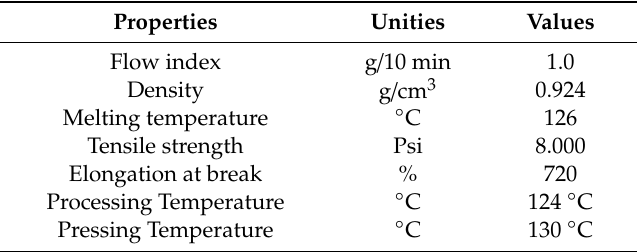
Table 1. Linear low-density polyethylene (LLDPE) features provided by the manufacturer and processing variables for composites (LLDPE-GTR) with the Brabender mixing